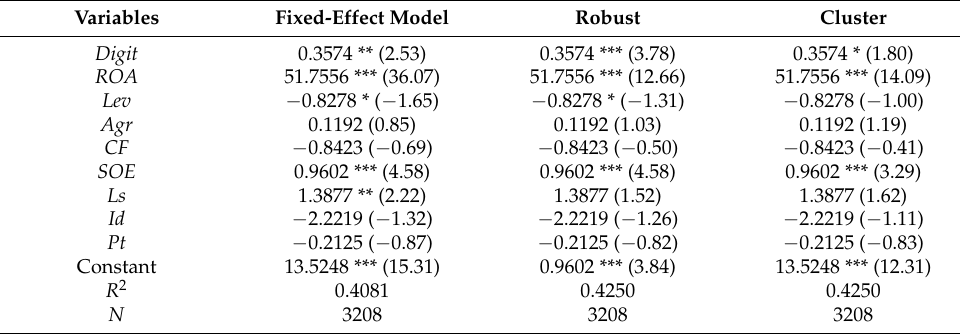
Table 5. Regression Result of Panel Data Fixed Effect Model.